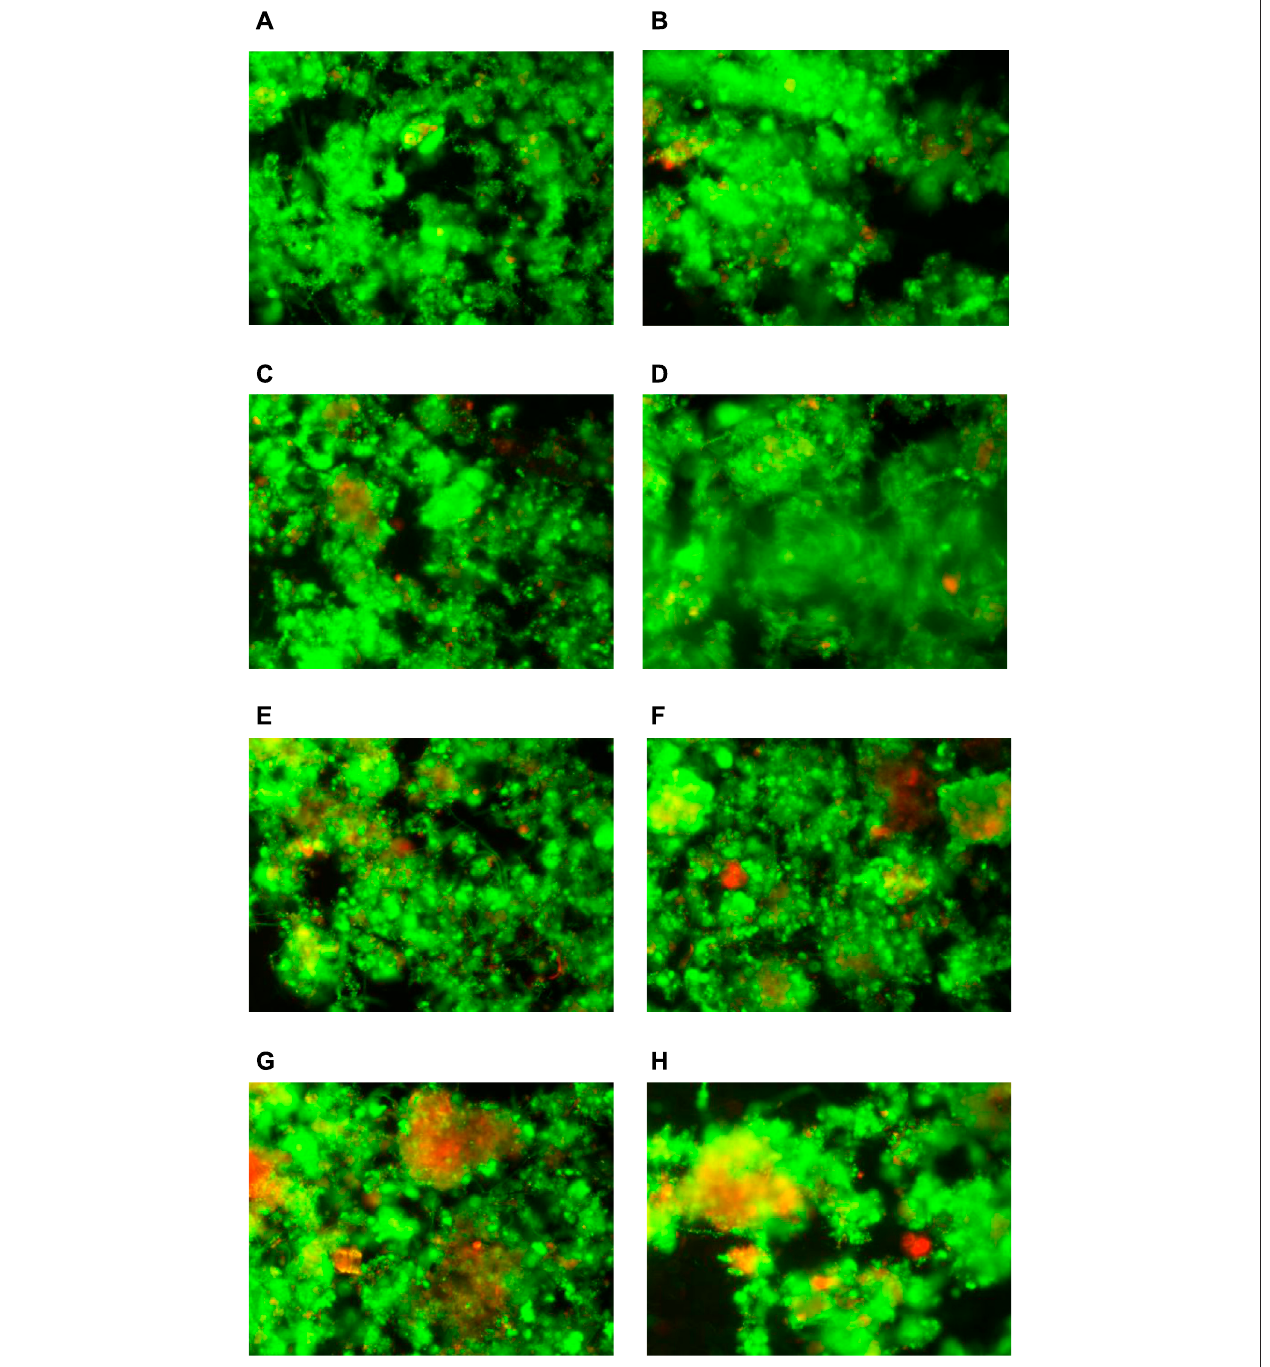
FIGURE 4 | Photos of live – dead: (A) raw sludge; (B) 20 mgCaO 2 /gVSS; (C) CaO 2 (20 mg/gVSS)/MW (40 ° C); (D) CaO 2 (20 mg/gVSS)/MW (50 ° C); (E) CaO 2 (20 mg/gVSS)/MW (60 ° C); (F) CaO 2 (20 mg/gVSS)/MW (70 ° C); (G) CaO 2 (20 mg/gVSS)/MW (80 ° C); (H) CaO 2 (20 mg/gVSS)/MW (90 ° C).